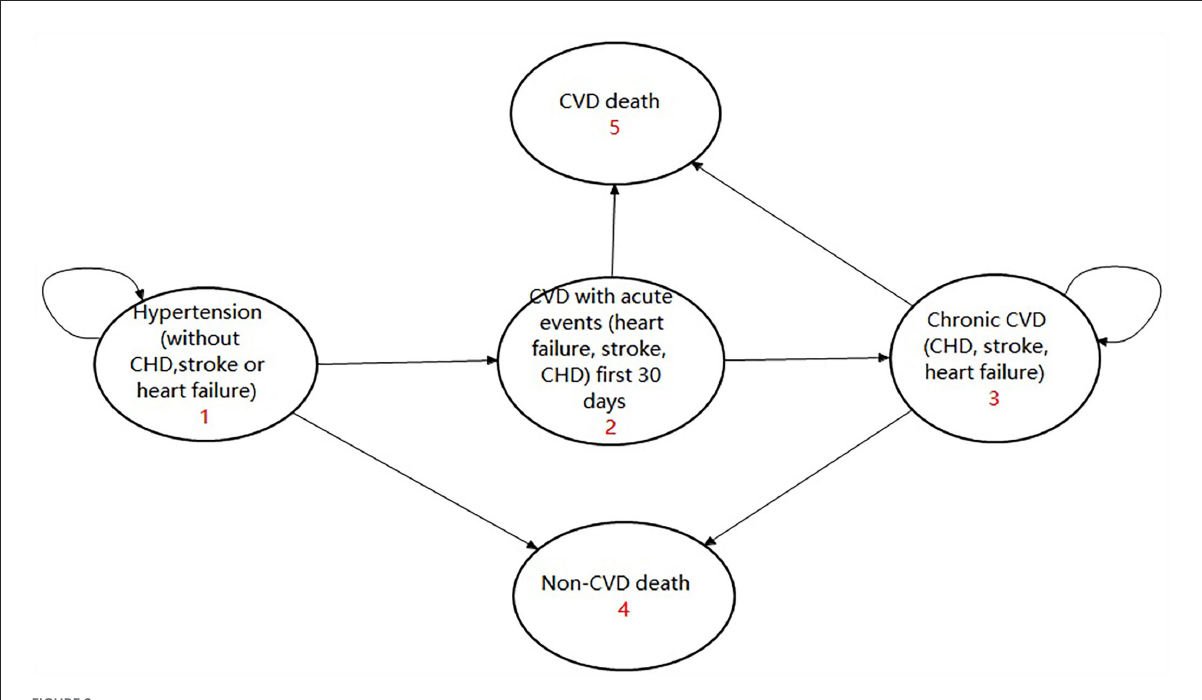
FIGURE2 Markov model using state transition